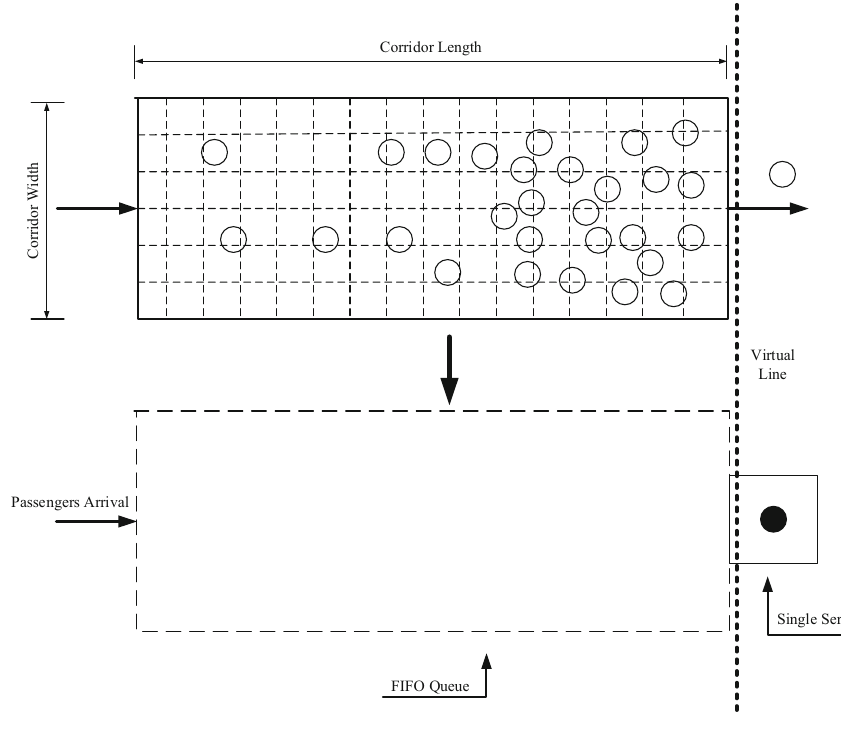
walkway to a single-server queuing